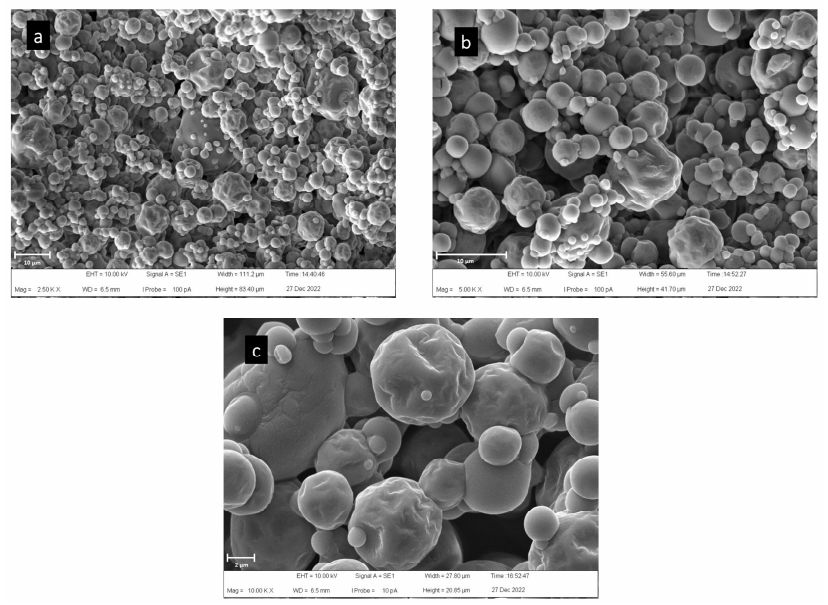
Figure 5. SEM micrographs of spray-dried beverage powder at 2500 × ( a ), 5000 × ( b ) and 10,000 × ( c ) magnification.